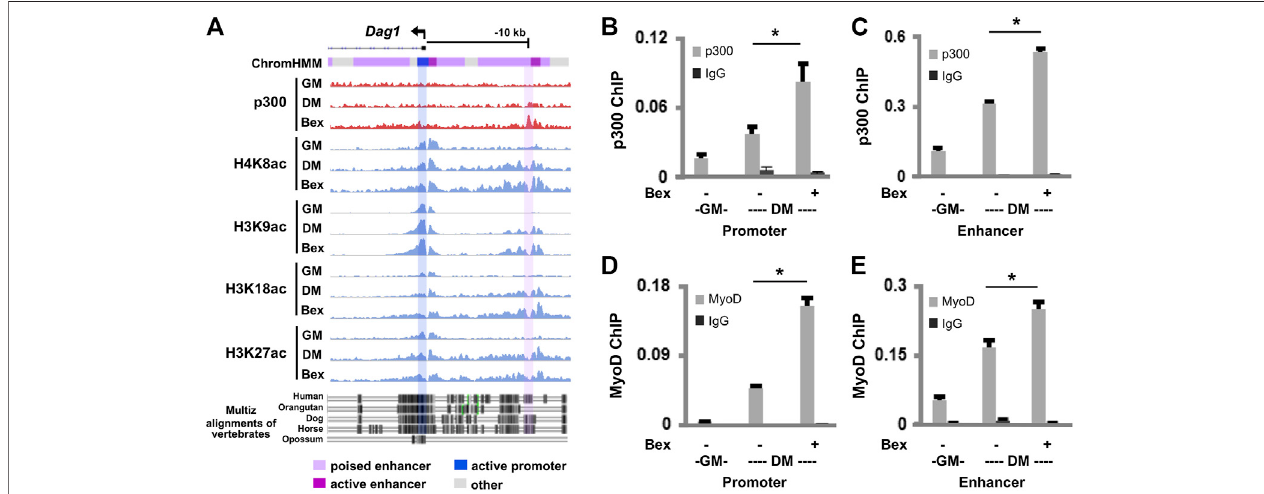
FIGURE2| p300andMyoDoccupancyatthe Dag1 locus. (A) Genomebrowserviewofp300andtheindicatedhistoneacetylationenrichmentsignalsatthe Dag1 locus. Black bars show Ref-seq gene position and the ChromHMM track coded by the color designated to each chromatin state. The bottom panel displays the conservation of the Dag1 locus from the alignment ofmulti-vertebratesusing theUCSC genomebrowser. The C2C12 myoblasts were differentiated for 24 h (DM) in the presence or absence of bexarotene (Bex, 50 nM) with proliferating myoblasts as controls (GM). Quantitative ChIP analysis was performed for the Dag1 promoter and the putative enhancer, using antibodies speci fi cally against p300 (B,C) or MyoD (D,E) . Normal IgG antiserum was used as a negative control. Quanti fi cation is presented as the percentage of enrichment in relation to the input chromatin DNA ( n = 3; * p < 0.05).